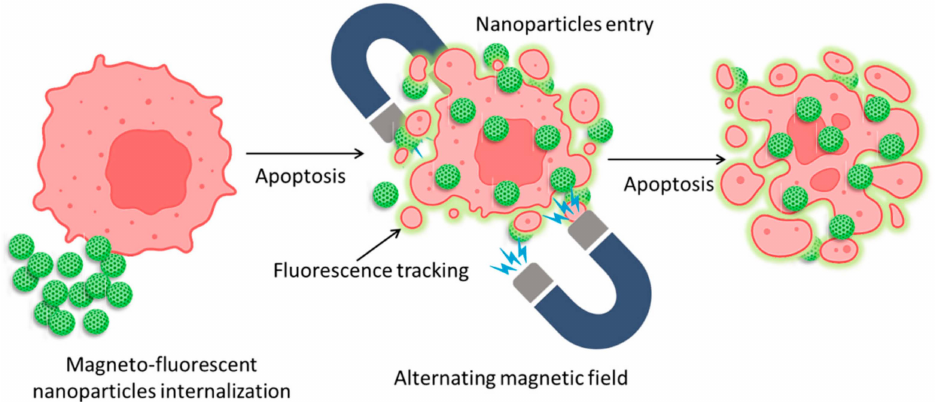
Figure 6. Mechanism of magnetic nanoparticle internalization into cancer cells and their tracking and apoptotic behavior against an alternating magnetic